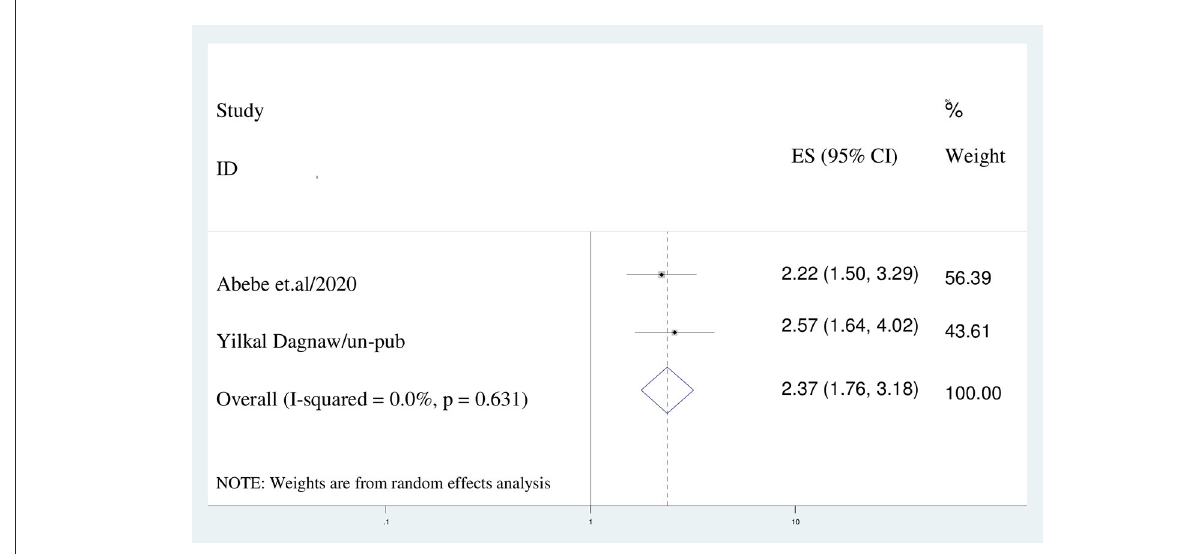
FIGURE8 The association between a desire to be pregnant and discontinuation of long acting reversible contraception.